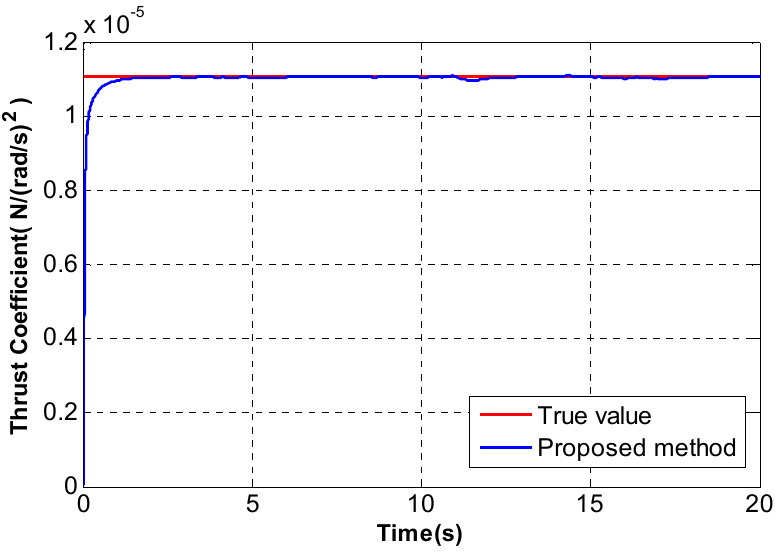
Figure 12. Thrust coefficient estimation value.